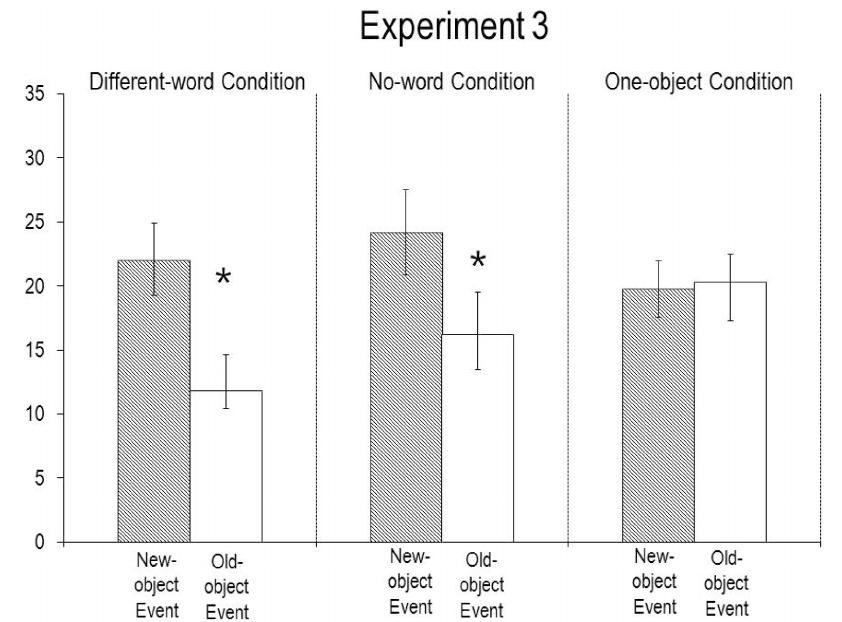
Figure 4. Mean looking times (s) of the infants in Experiment 3 during the test trials. Errors bars represent standard errors, and an asterisk denotes a significant difference between the events within a condition (p , .05 or better). condition, F (1, 28) = 7.32, p , .025 (the 7-month-olds looked longer if shown the new- as opposed to old-object event, whereas the 12-month-olds looked equally at both events).